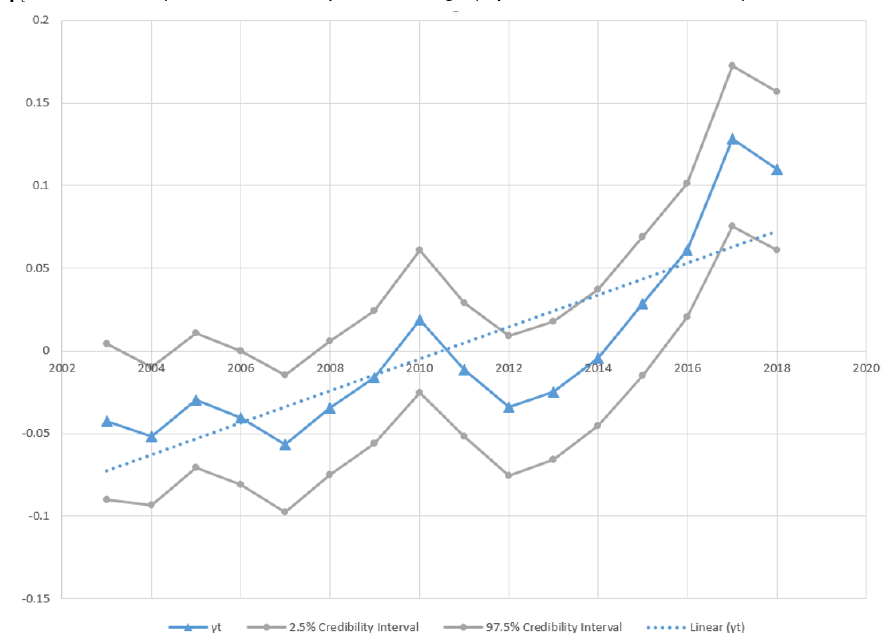
Figure 6. Temporal structure of Bayesian hierarchical spatial temporal model for census tract-level SUHI intensity with percentage of each demographic group within the tract as an explanatory var- iable. γt is the temporally structured effect modeled as a random walk of order 1 (RW1). Line of best fit is determined by ordinary least squares univariate linear regression. n = 711,616. Gray lines are 95% credibility values. Dased line is the line of best fit derived from ordinary least squares linear regression.